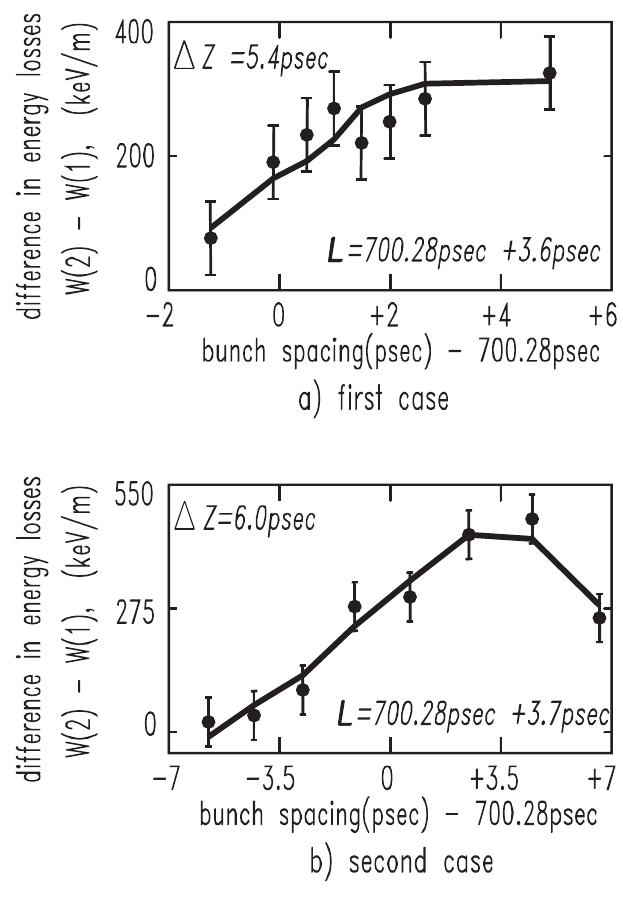
FIG. 6. Measured difference in energy losses (marked by